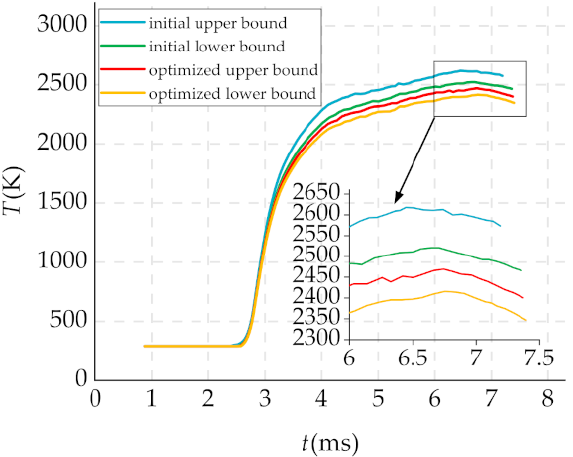
Figure 23. The initial and optimized interval of the propellant gas temperature.